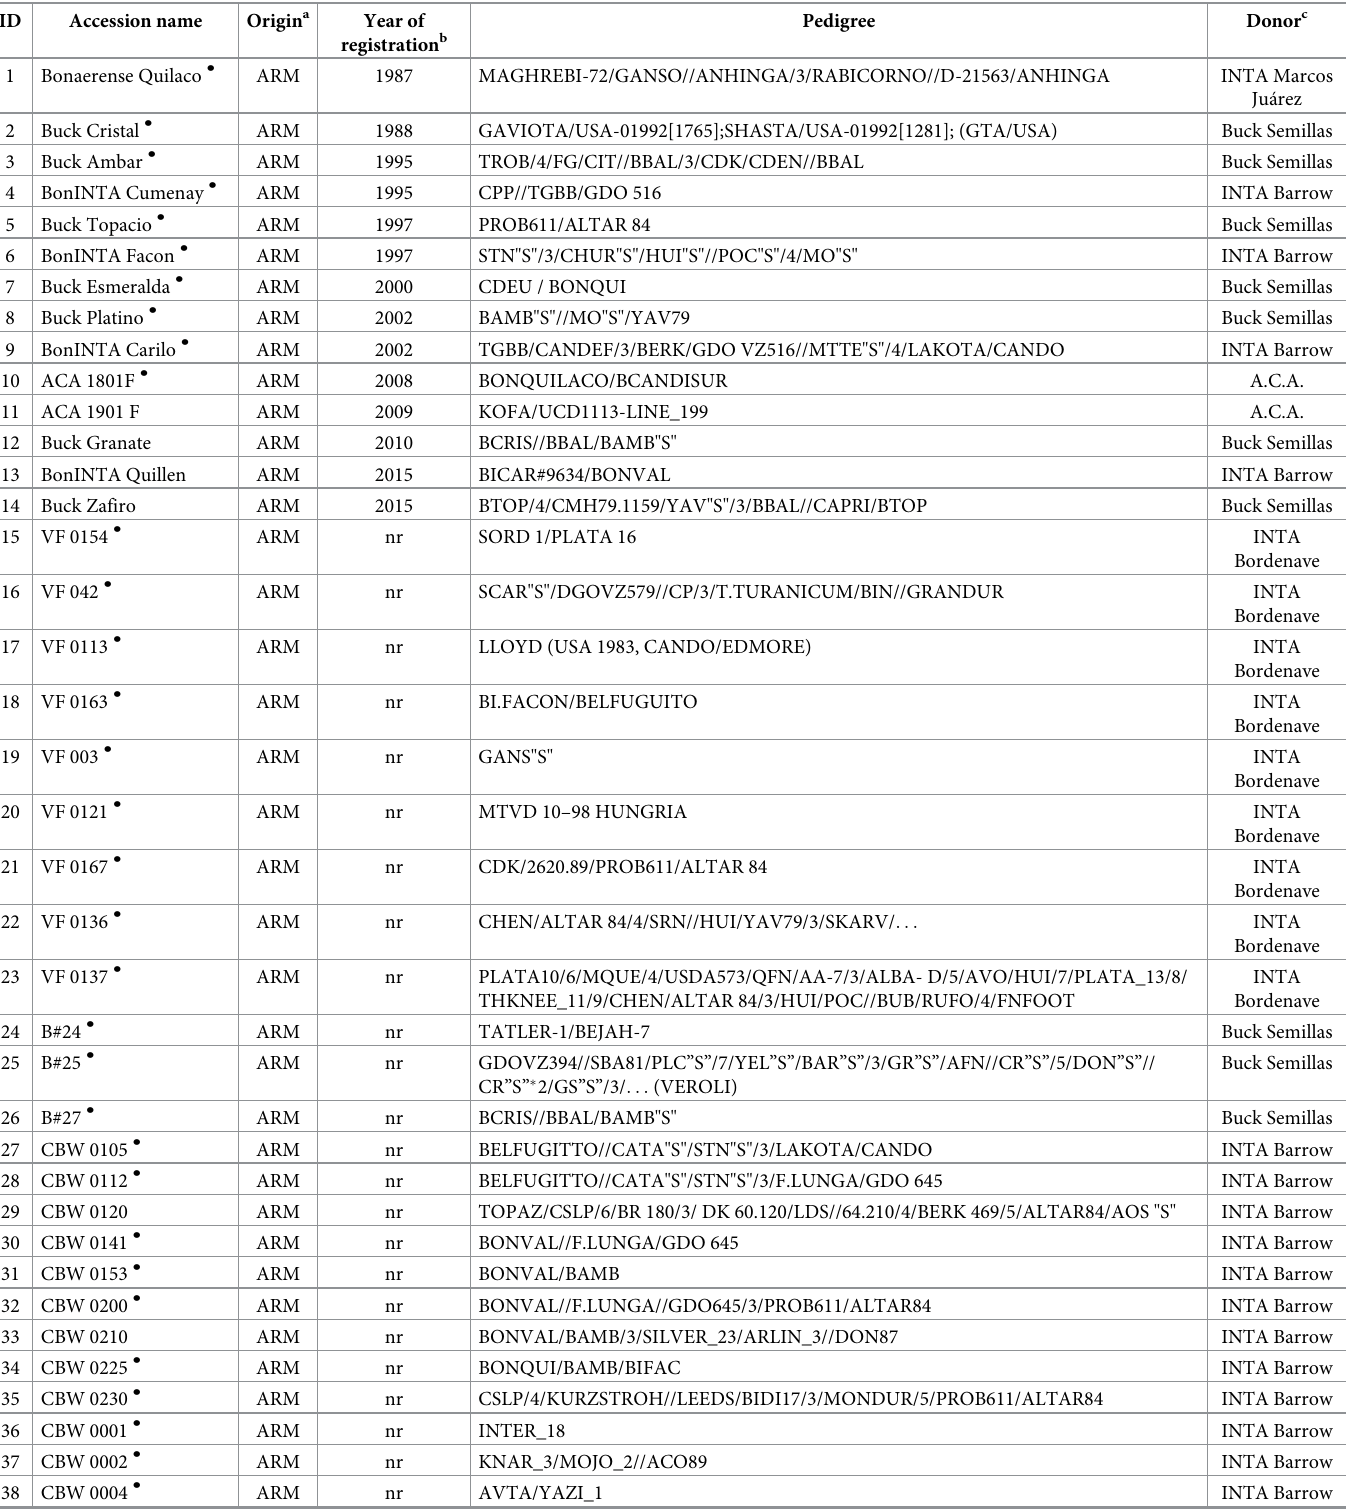
Table 1. List of the 168 durum wheat accessions (cultivars, breeding lines and landraces) analyzed in this